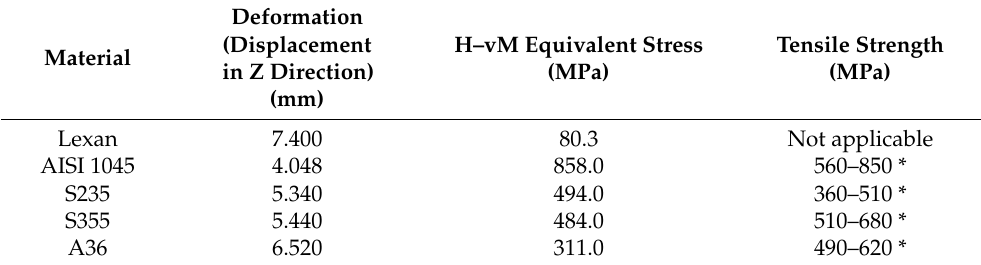
Table 4. Impact test results for the studied toecap types in relation to the tensile strength of the materials used.